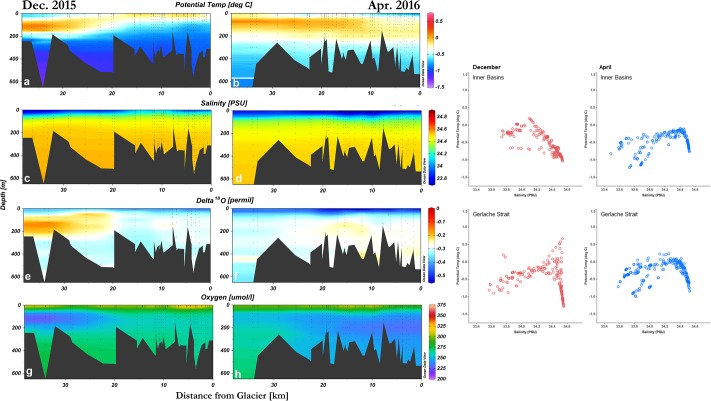
Overall hydrography profiles of Andvord Bay in December 2015, and April 2016.Left panels: Cross section plots of Andvord Bay depicting (a, b) potential temperature, (c, d) salinity, (e, f) oxygen isotope ratio, and (g, h) dissolved oxygen concentration, and as a function of their distance relative to the main glaciers situated in Andvord Bay. The differentiation between bottom topography is due to the slight differences in transect and sampling locations between the two study periods. Right panels: Temperature-salinity profiles of water masses within the inner basins and Gerlache Strait.